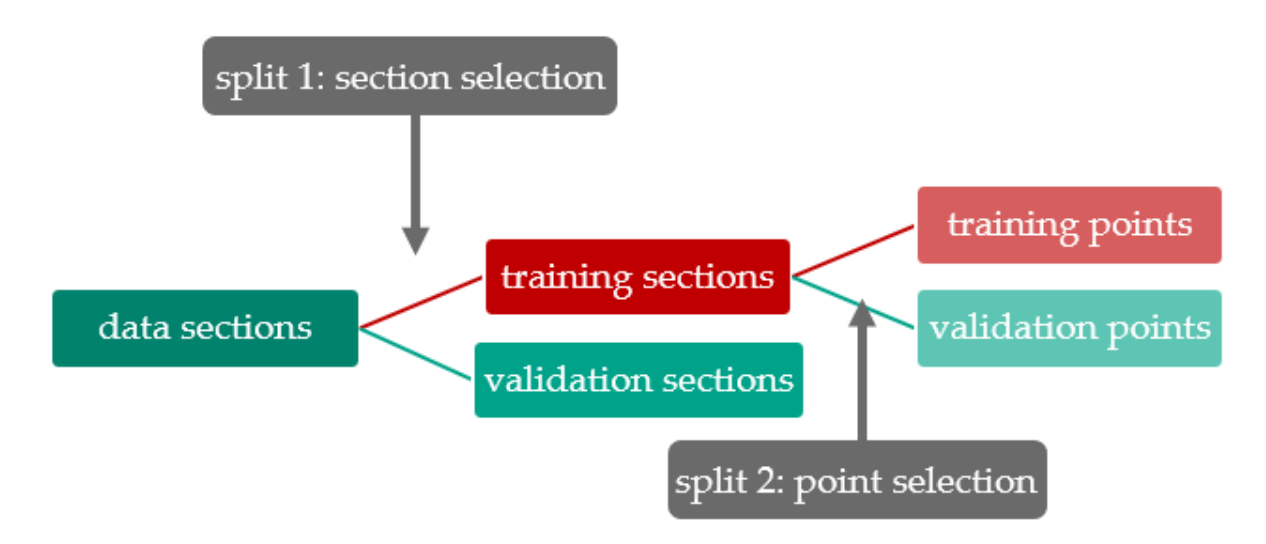
Figure 3. Data split for model training and validation.